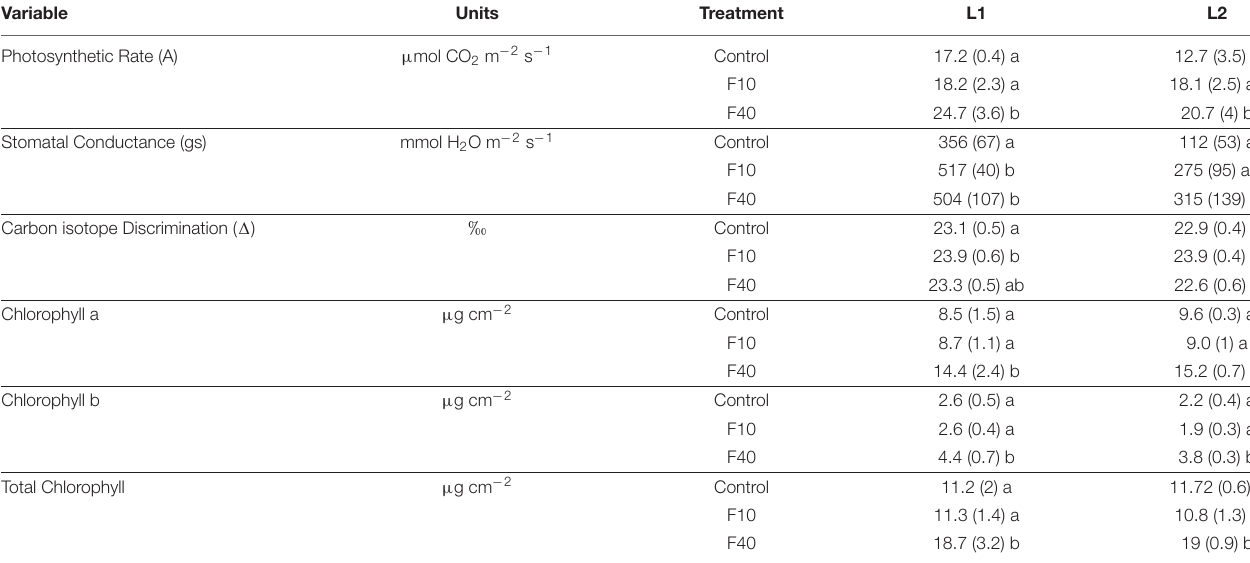
TABLE 2 | Gas exchange and biochemical traits in a leaf expanded during flooding (L1) and a leaf expanded during post-flooding (L2). Variable Photosynthetic Rate